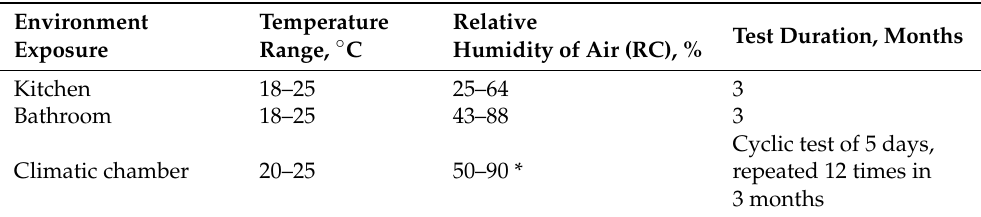
Table 1. The exposure conditions for the blockboard panels.